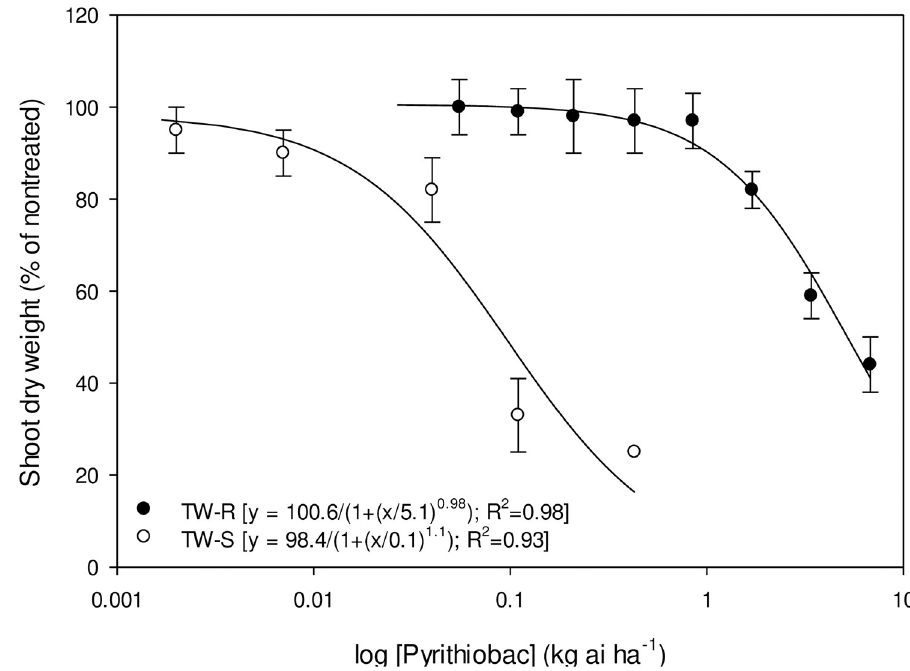
Fig 4. Pyrithiobac dose response on shoot dry weight reduction of ALS-inhibiting herbicide-resistant (TW-R) and -susceptible (TW-S) Amaranthus tuberculatus populations from Mississippi 3 wk after treatment. Vertical bars represent standard error of mean.